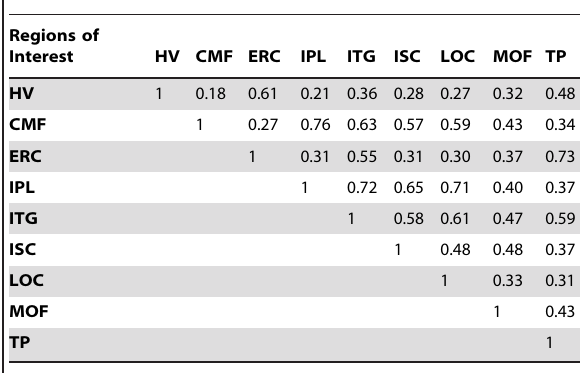
Table 4. Correlation results between cortical thickness of eight neocortical ROIs and total hippocampal volume in only MCI individuals